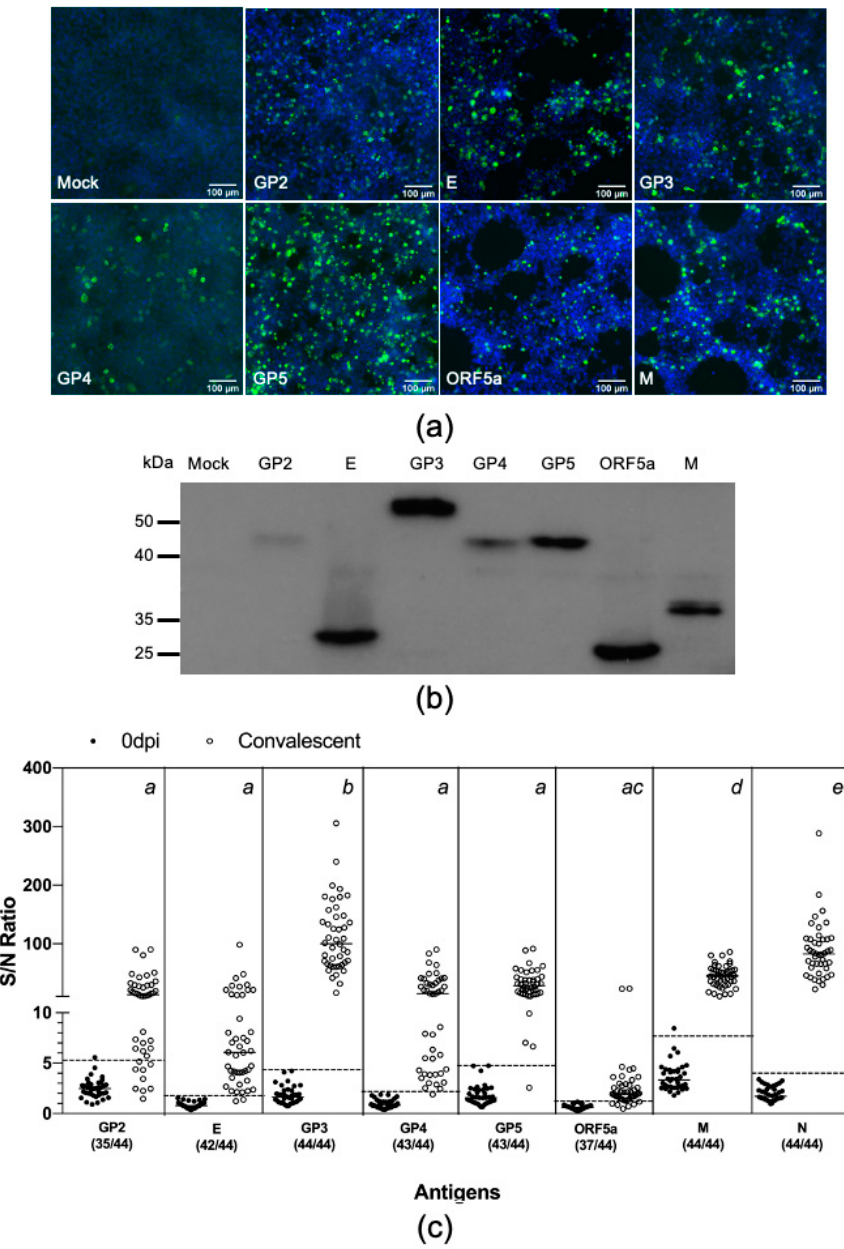
3 Figure 3. Swine antibody reactivities against PRRSV structural proteins. ( a , b ) Evaluation of protein expression. HEK-293T cells were transfected with plasmids encoding Nluc-tagged antigens. At 60 h post-transfection, cells were fixed and subjected to IFA and immunoblotting analysis as described in the Figure 2 legend. ( c ) Thirty-eight serum sample collected before infection (0 dpi) and 44 samples collected at between 42 and 63 dpi from 44 pigs experimentally infected with the PRRSV strain FL12. The antibody reactivities of these serum samples were simultaneous measured against eight PRRSV structural proteins as described in Materials and Method. Fetal bovine serum (FBS) was used as negative control. Data are expressed as sample to negative (S / N) ratios. The dotted lines indicate the cuto ff s of the respective assays. The numbers within parenthesis below the antigen names indicate the proportion of convalescent serum samples tested positive for that respective antigens. One-way analysis of variance (ANOVA) was used to evaluate the di ff erence among the mean S / N ratios of the convalescent antisera, followed by Tukey’s multiple comparison test. The superscript letters at the top of the graph denote the statistical comparison of the S / N ratios among the eight antigens. Means sharing the same superscript are not significantly di ff erent from each other ( p >